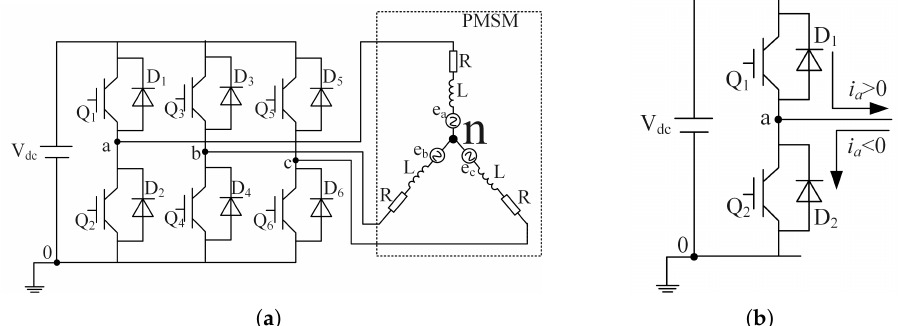
Figure 1. Model component. ( a ) Three-phase PWM drive system. ( b ) One phase leg of the PWM